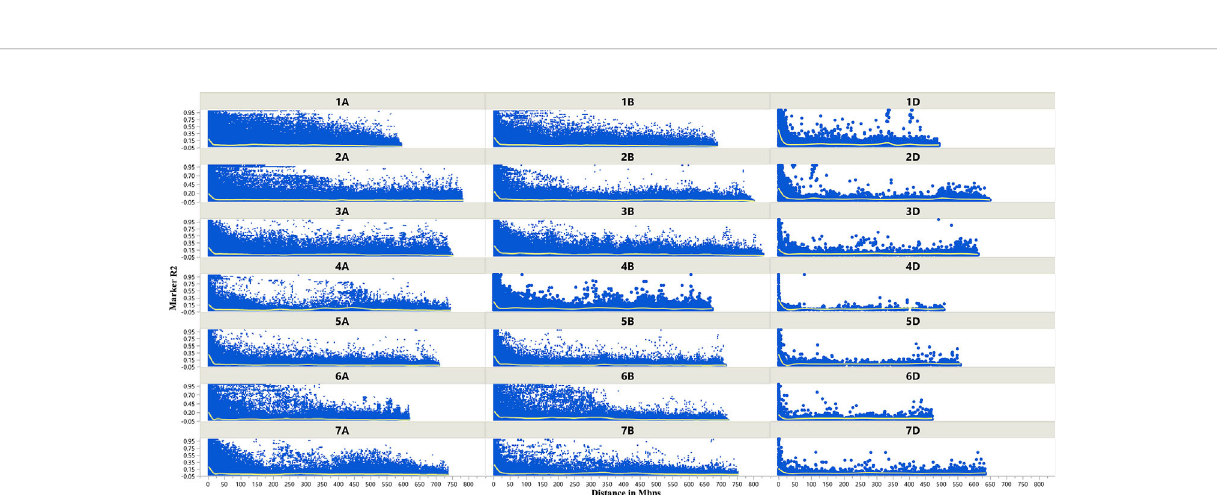
FIGURE 3 | Scatter plot showing linkage disequilibrium (LD) decay across the chromosomes of wheat. Physical distance in Mb is plotted against the LD estimate ( R 2 ) for pairs of markers associated with tan